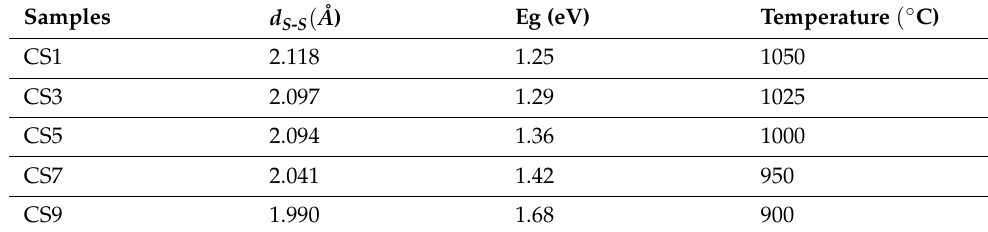
Table 5. Exprimental crystals paramaters.